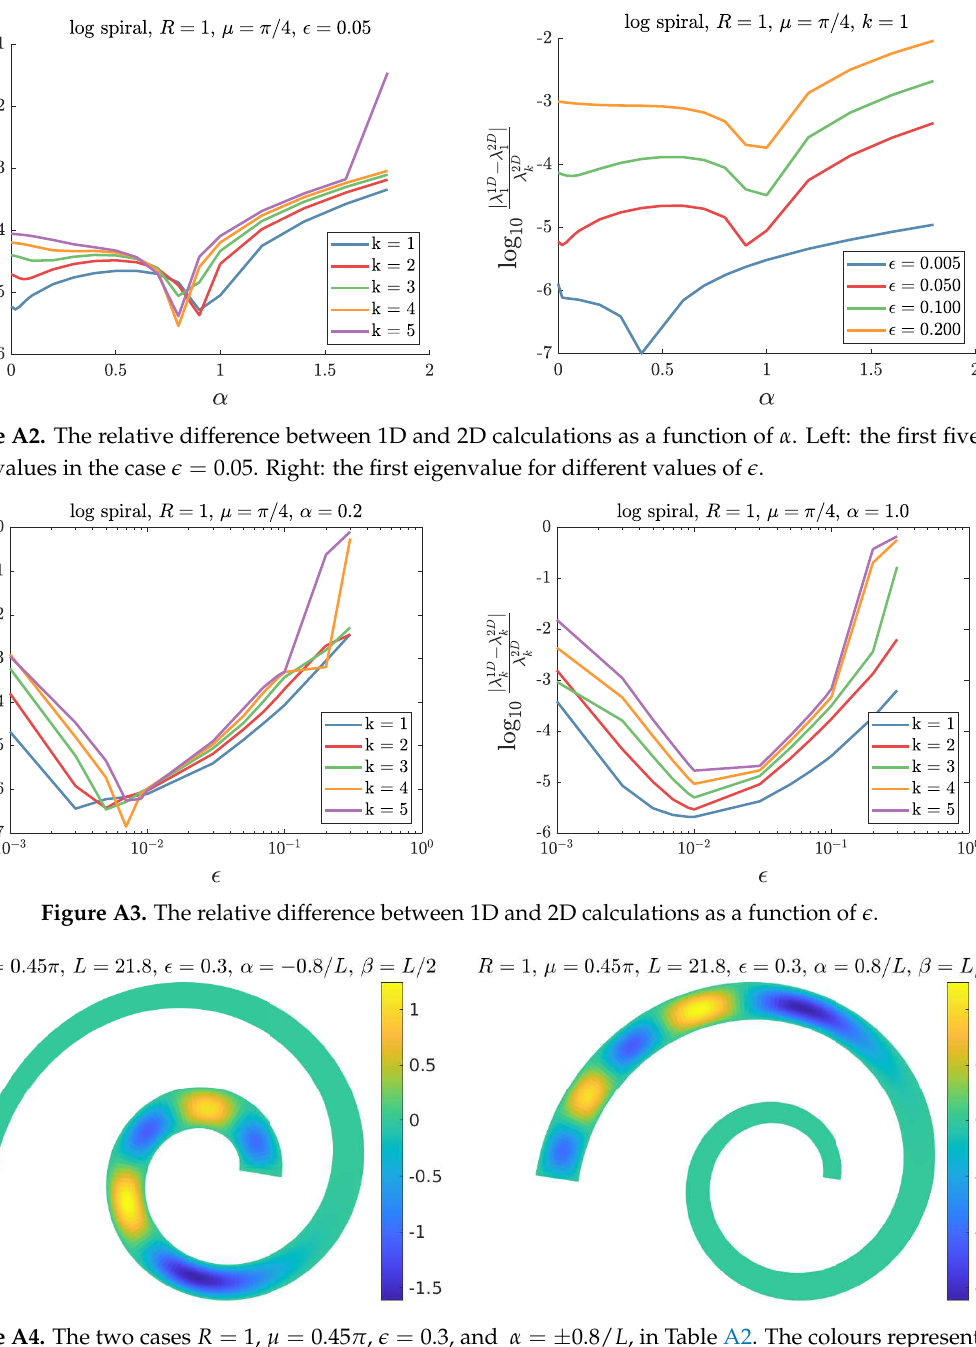
Figure A4. The two cases R = 1, µ = 0.45 π , (cid:101) = 0.3, and α = ± 0.8/ L , in Table A2. The colours represent the fifth eigenfunction calculated based on the 2D